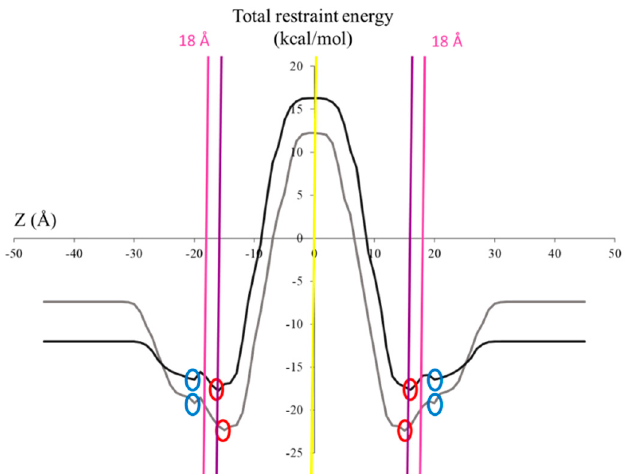
Figure 13. IMPALA simulation of Saponin O (dark line) and Saponin O h (grey line) traversing a 36 Å thick implicit membrane. The “energy-like” profile of the saponin traversing the implicit bilayer. The Z-axis corresponds to the position of the center of mass of the saponin along an axis orthogonal to the membrane, the center of the bilayer corresponding to the intersection with the Y-axis. The different circles represent the two most stable positions of both molecules the center of the bilayer corresponds to the Y-axis with the red circles corresponding to the most stable positions. The vertical lines represent the water/membrane interface (pink), the hydrophilic head/hydrophobic tail interface of the phospholipid bilayer (purple), and the center of the bilayer (yellow).